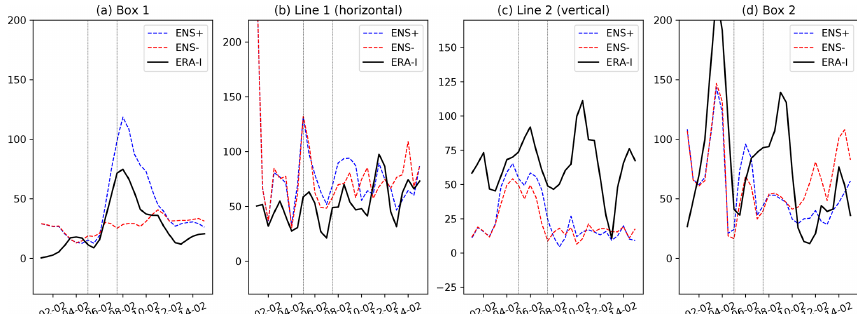
Figure 12. Time series of the horizontal WAF at 500hPa (m 2 s − 2 ) averaged over boxes 1 and 2 and through lines 1 and 2 shown in Fig. 11c. Panels (a) and (d) show mean length of the horizontal WAF vector, while panels (b) and (c) show mean meridional and zonal components, respectively. Grey vertical lines denote the averaging period taken for analysis in Fig. 11: 5 and 7